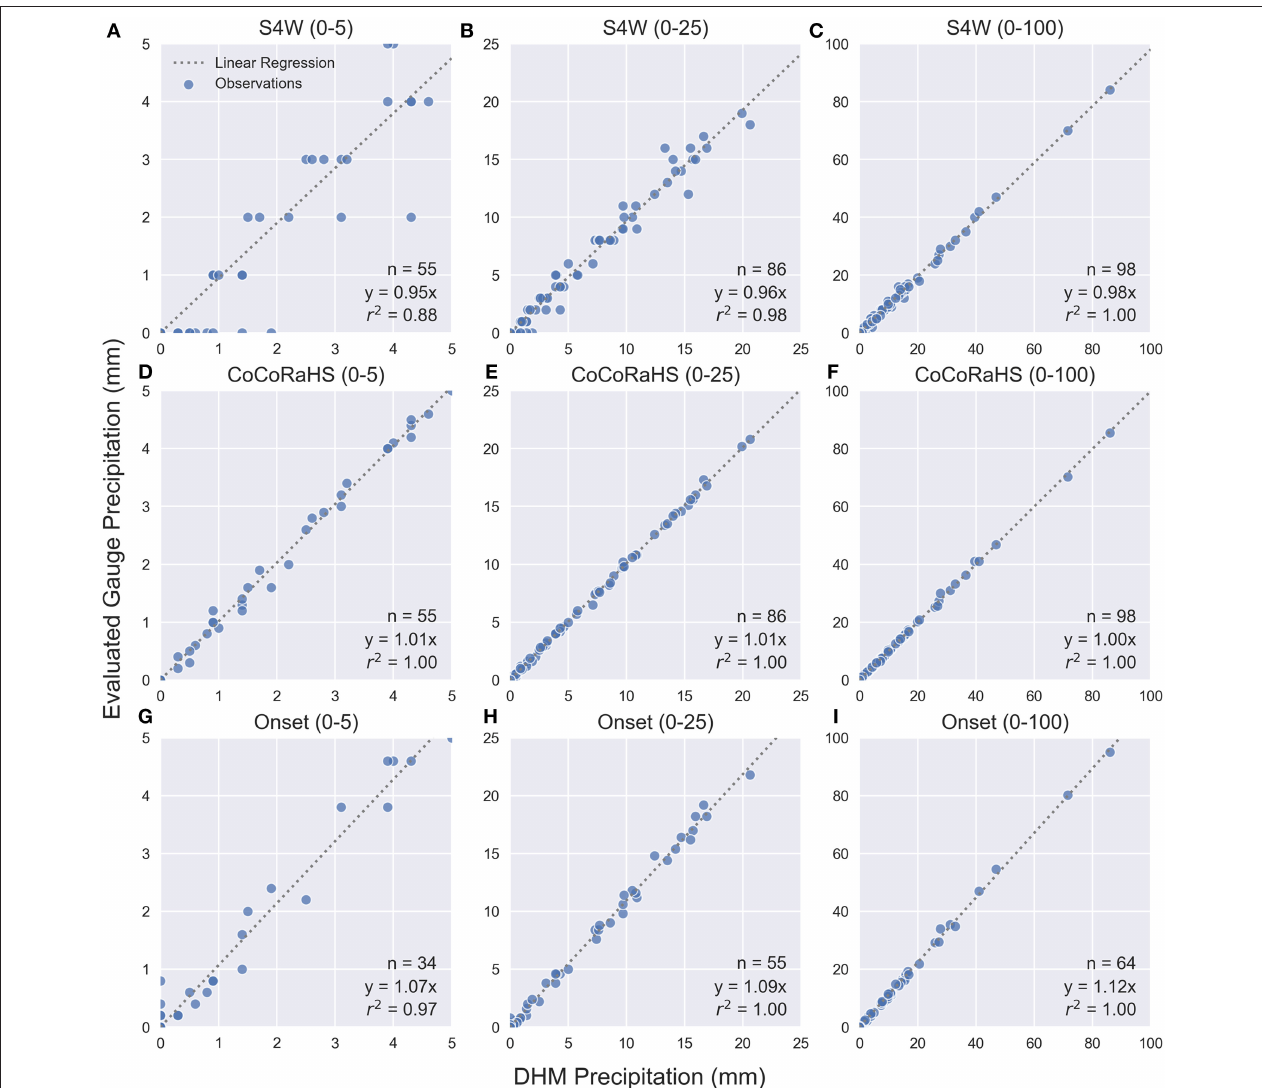
FIGURE 5 | Comparison of precipitation data from S4W, CoCoRaHS, and Onset gauges using DHM observations as the reference (i.e., horizontal axis). Per reference DHM measurements, data was filtered into three precipitation event ranges: 0–5mm [i.e. panels (A,D,G) ], 0–25mm [i.e., panels (B,E,H) ], and 0–100mm [i.e., panels (C,F,I) ]. No precipitation events above 100mm were recorded. Data shown are from May 1st, 2017 through April 30th, 2018. The period of record for the Onset gauge was June 3rd, 2017 to November 27th, 2018; only fully overlapping data sets between Onset and DHM were used, resulting in decreased sample sizes for panels (G–I)